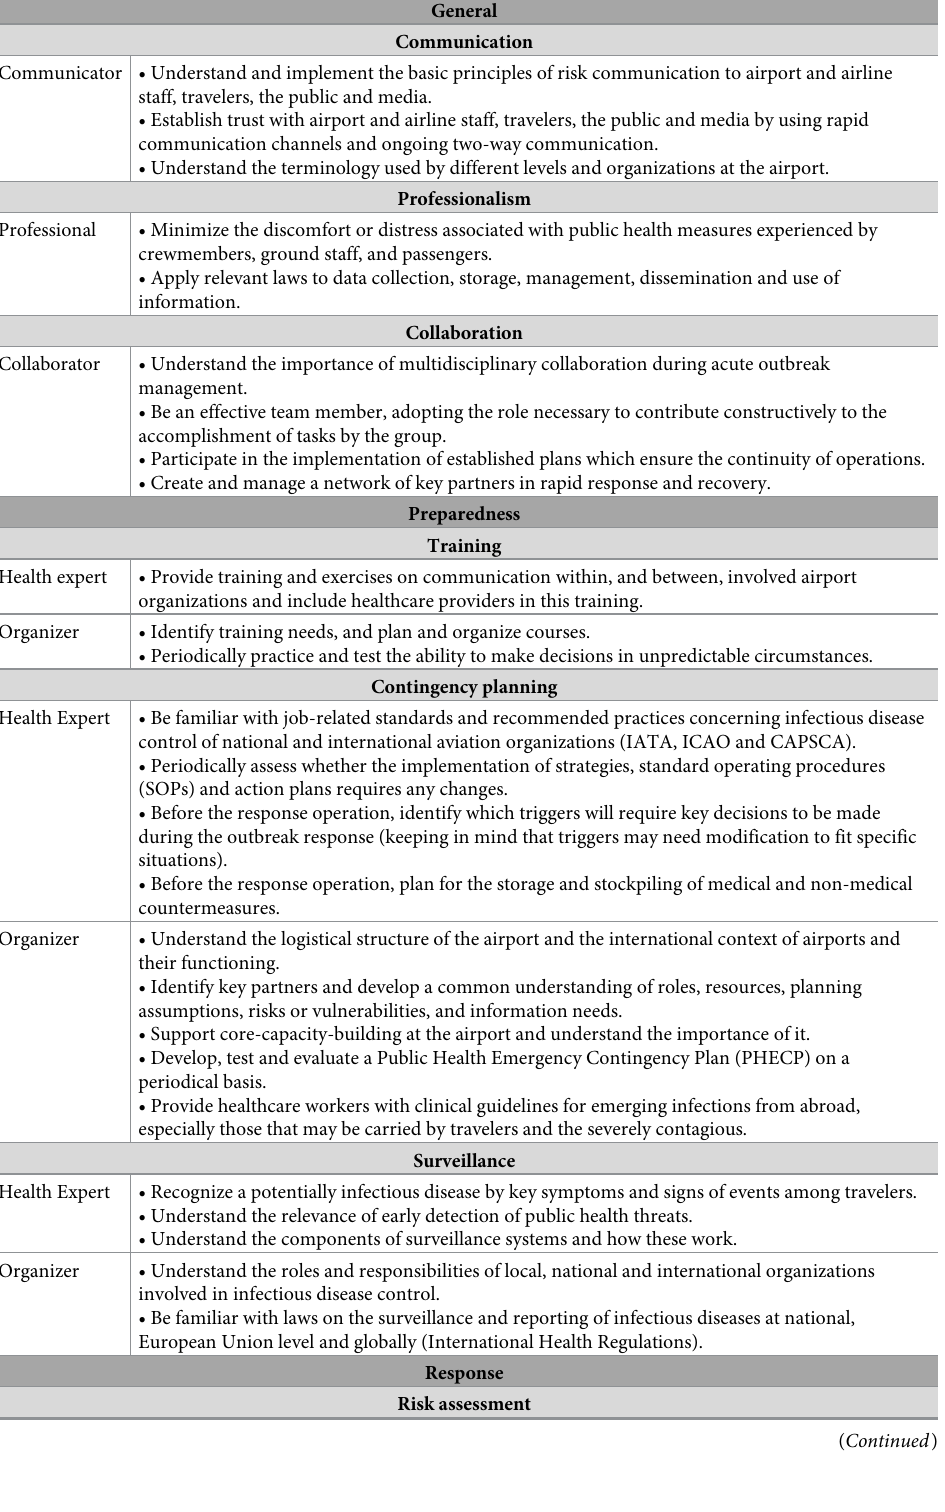
Table 4. Competency profile for professionals involved in infectious disease preparedness and response at